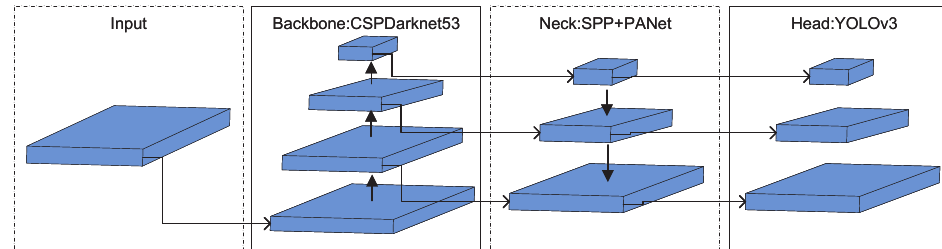
Figure 1. YOLOv4 structure